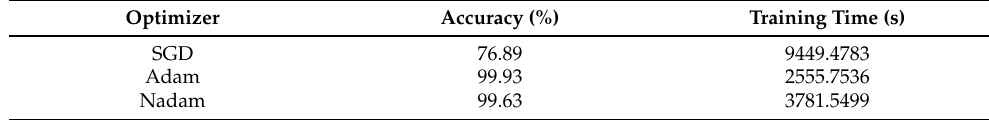
Table 5. Accuracy at different optimizers θ [ B = 32, I = 64 × 64, R =